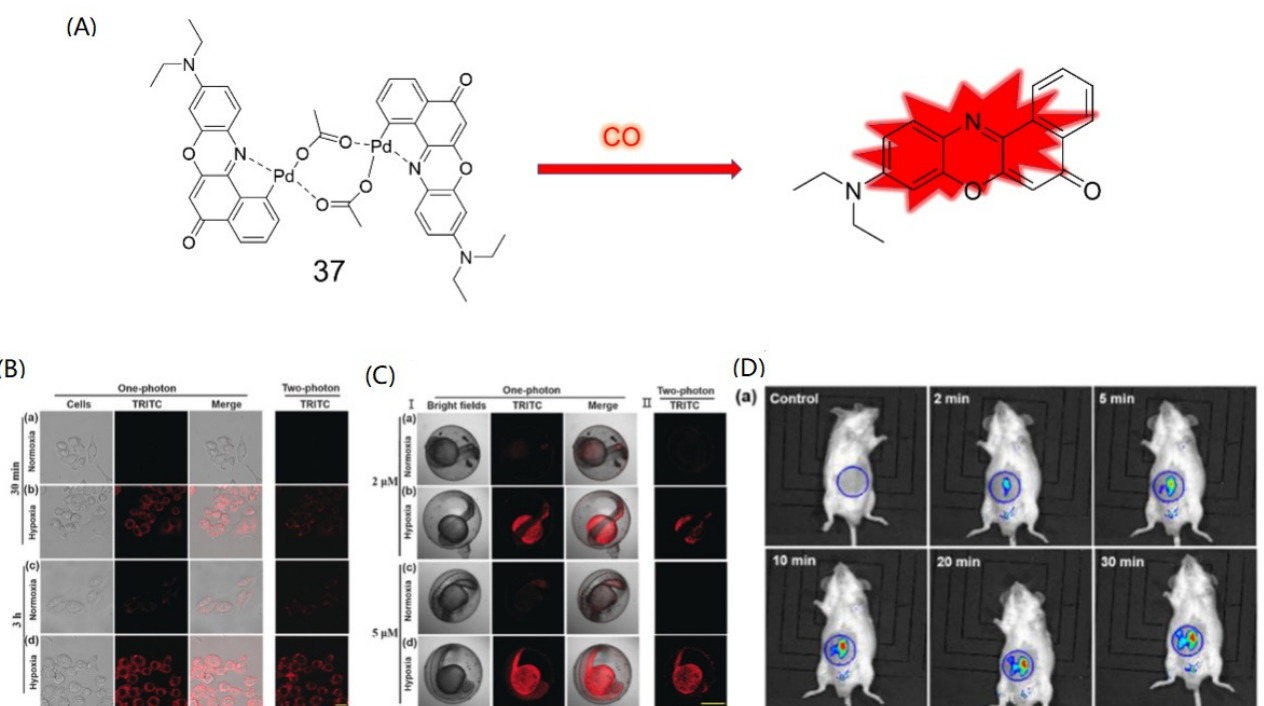
Figure 14. ( A ). The principle of probe 36 for the detection of CO. ( B – D ). Fluorescence imaging of probes to detect exogenous CO in cells, zebrafish and mice. Copyright (2017) Angewandte Chemie [47].